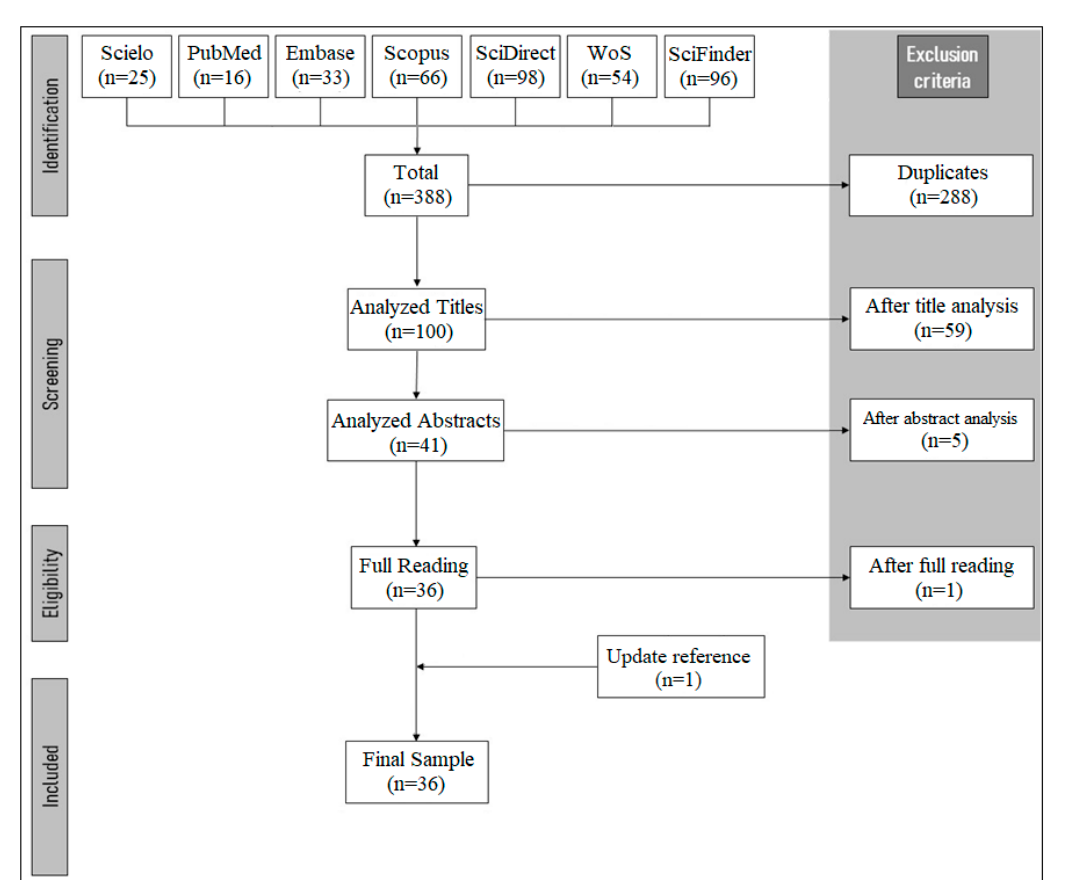
Figure 3. Flow chart of the articles selection process according to PRISMA-ScR.